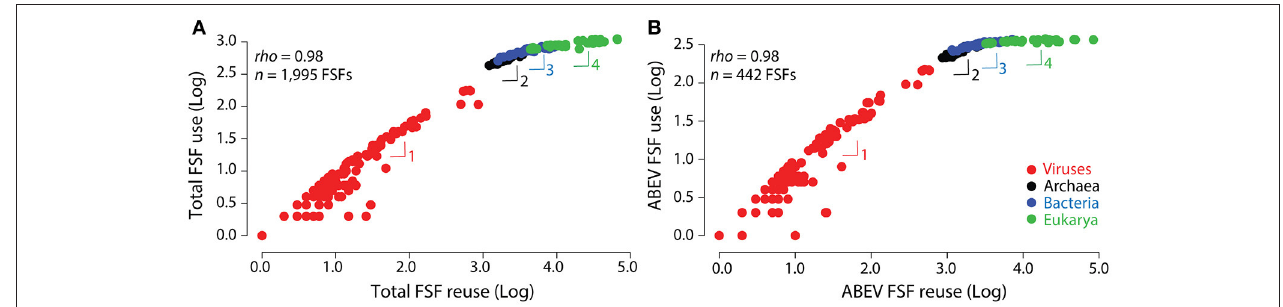
FIGURE 2 | FSF use (occurrence) and reuse (abundance) are strongly correlated. Scatter log-log plots reveal a strong correlation between FSF use and FSF reuse for total (A) and universal ABEV FSF (B) sets for 368-taxon trees (Nasir and Caetano-Anollés, 2015). Viruses (266), Archaea (34), Bacteria (34), and Eukarya (34) are colored red, black, blue, and green, respectively. Each of these supergroups has its own power law regime that complies with a four-regime Heaps law of vocabulary growth. Individual regimes are indicated with numbers and follow V ∼ N β relationships, with V representing FSF vocabulary size ( use ) and N representing FSF database size ( reuse ) in proteomes. Their fits to linear regression models using ordinary least squares and the estimation of the Heaps exponent β are described in Figure S2.